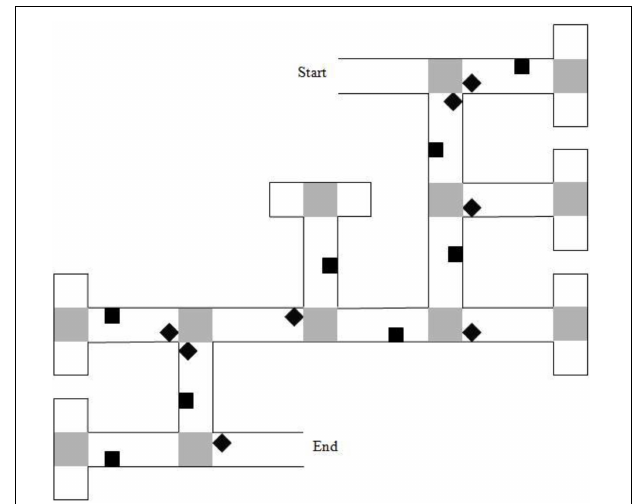
error of one would give a proportion of 0.5. The mean proportion